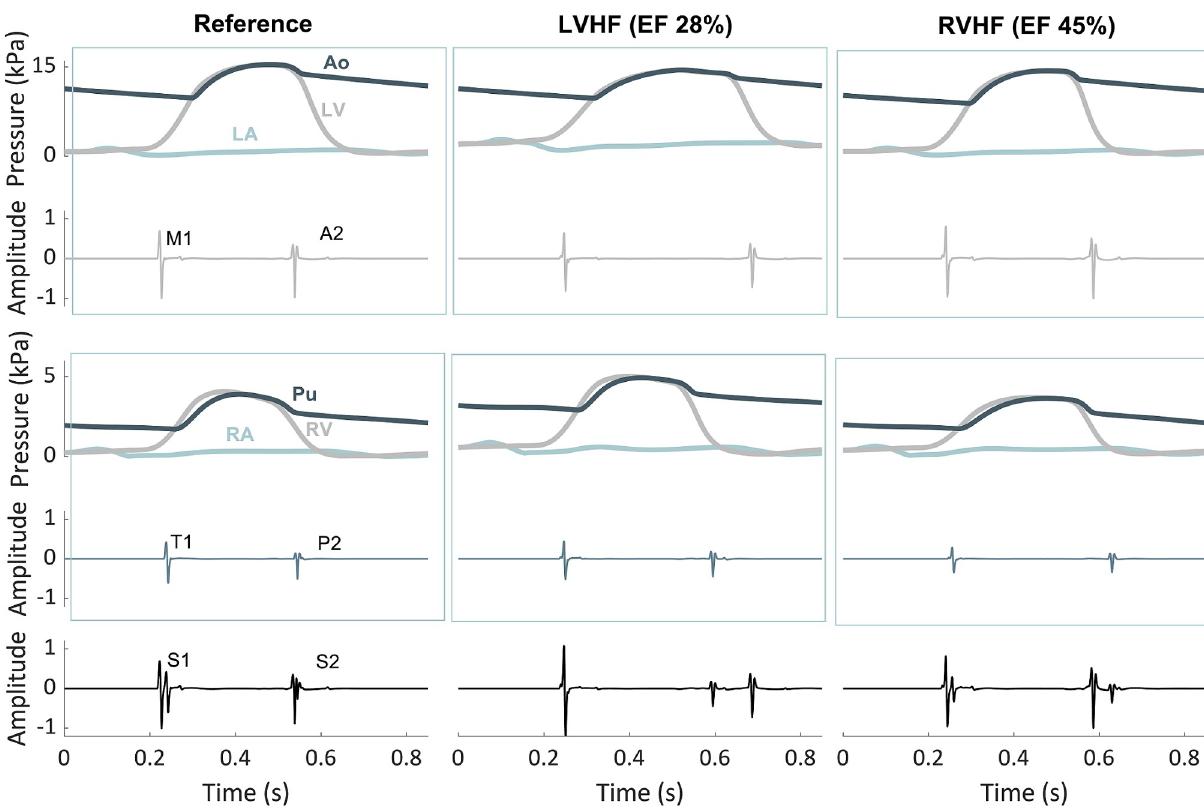
Fig 4. Simulated heart sounds and pressures at reference and left/right heart failures. EF : ejection fraction.